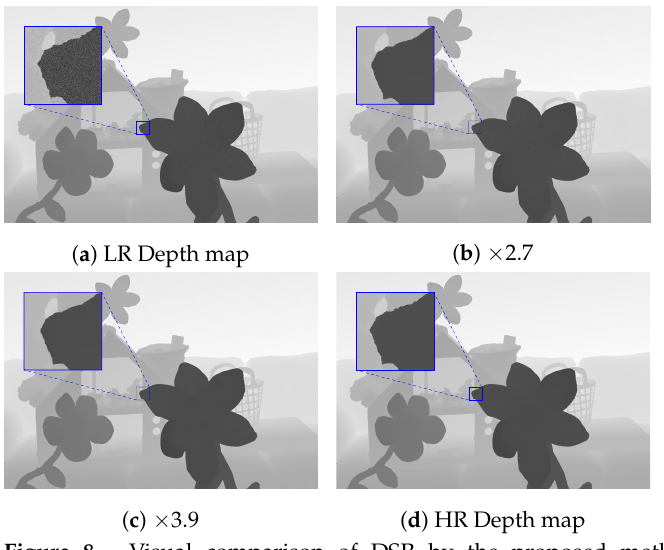
Figure 8. Visual comparison of DSR by the proposed method on the noisy Middlebury dataset [17,49–52] with different scale